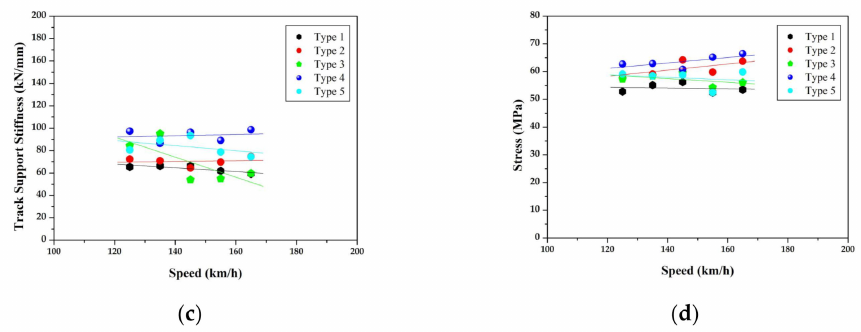
Figure 9. Dynamic stability evaluation result comparison for concrete track types: ( a ) wheel load fluctuation, ( b ) derailment coe ffi cient, ( c ) track support sti ff ness, and ( d ) rail stress. Table 9. Calculation result of track performance and dynamic stability according to railway structures per vehicle speed ranges (ballasted track structure types)